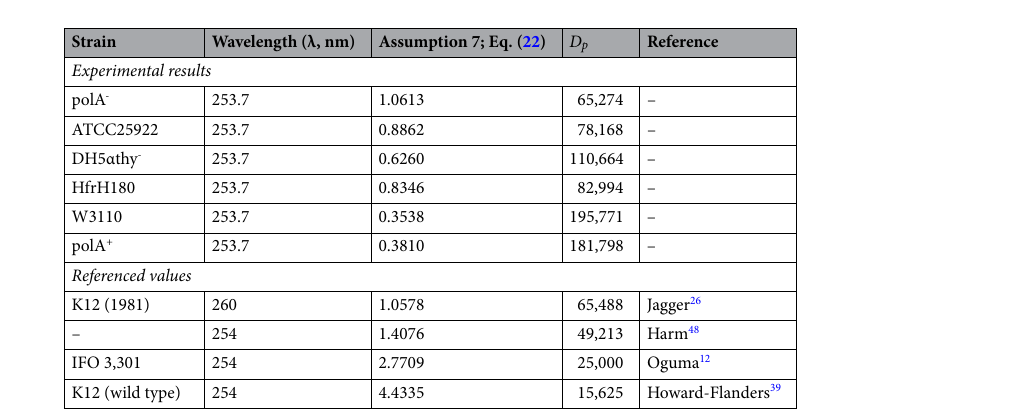
Figure 4. Graphical representation and calculated values of the measured parameters. SSM and R are presented in absolute values. R: correlation coefficient, R 2 : determination coefficient.